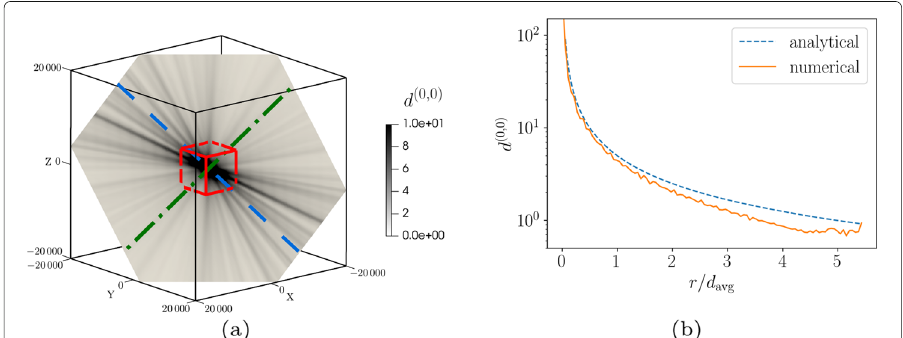
Fig. 14 Slice of the pair correlation d ( 0,0 ) on the image of the slip plane in distance space ( a ). The unit of the axes is the magnitude of the Burgers vector b . The domain was discretized with 121 subvolumes in each coordinate direction. The dashed blue line indicates the direction of the Burgers vector, i.e. the screw direction, the dash-dotted green line shows the edge direction. The central part of the domain (red box) is analyzed in more detail in Fig. 15. Comparison of in-plane (slip plane) angular averaged pair correlation d ( 0,0 ) with the analytical solution for arbitrarily distributed straight lines (cf. Eq. (108)) ( b ). The radius is measured in multiples of the average dislocation spacing d avg = 1 √ ρ ≈ 1.318 × 10 − 6